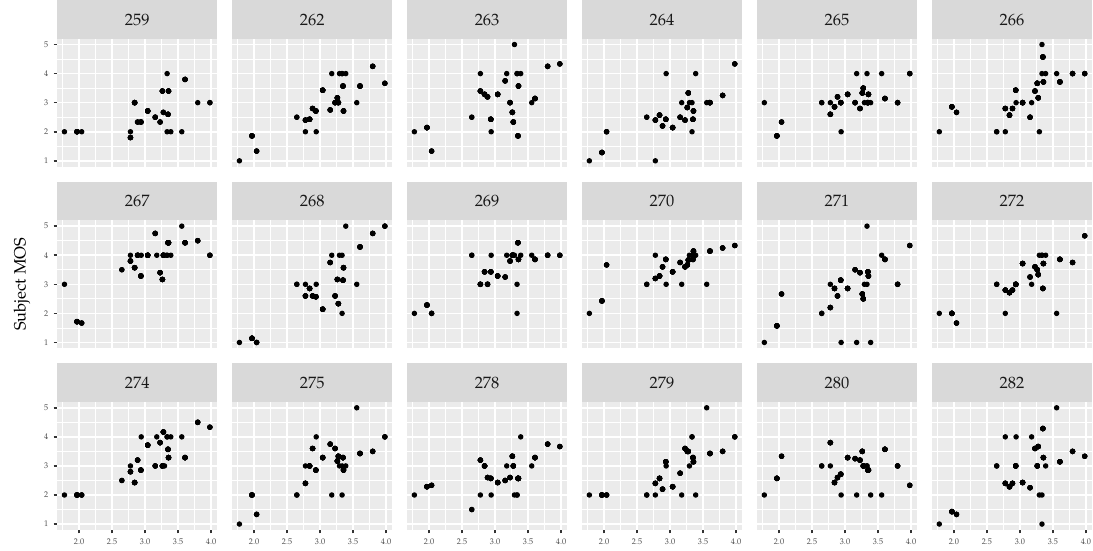
Figure 5. Scatter plots of each subject’s MOS (vertical axis) compared with the MOS of all subjects (horizontal axis). The data comes from the VIME1 data set. We calculate per-subject MOS scores by aggregating individual scores by camera types. There is almost no consistency in opinion